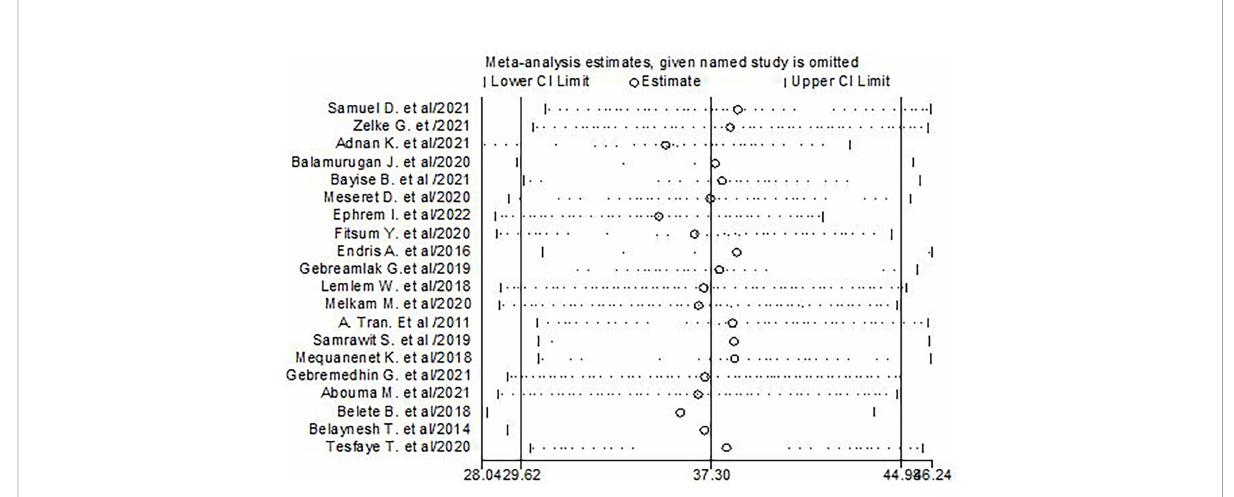
FIGURE 7 Results of sensitivity analysis of the 20 studies in the meta-analysis of central obesity.